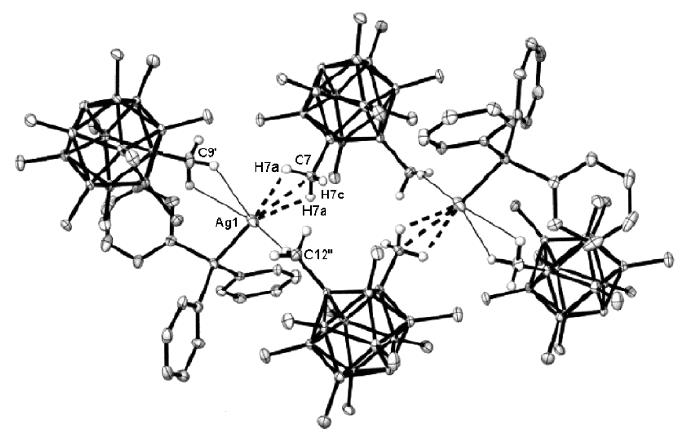
Figure 94. Fragment of X-ray structure of {(Ph 3 P)Ag[HCB 11 Me 11 ]}. Reproduced with permission from reference [111]. Copyright © (2002) John Wiley & Sons.